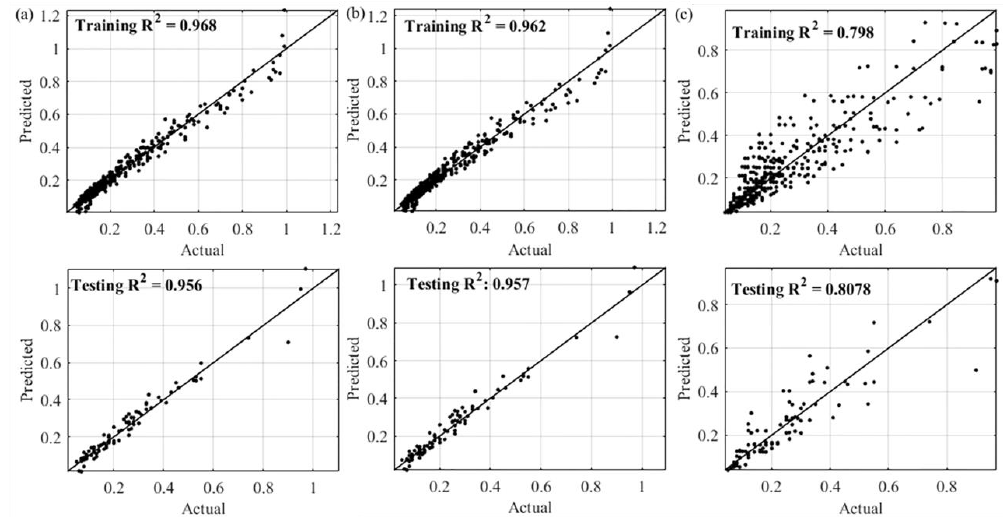
Figure 6. Scatter plot of the actual and MGGP predicted results: ( a ) Model A; ( b ) Model B; and ( c ) Model C.